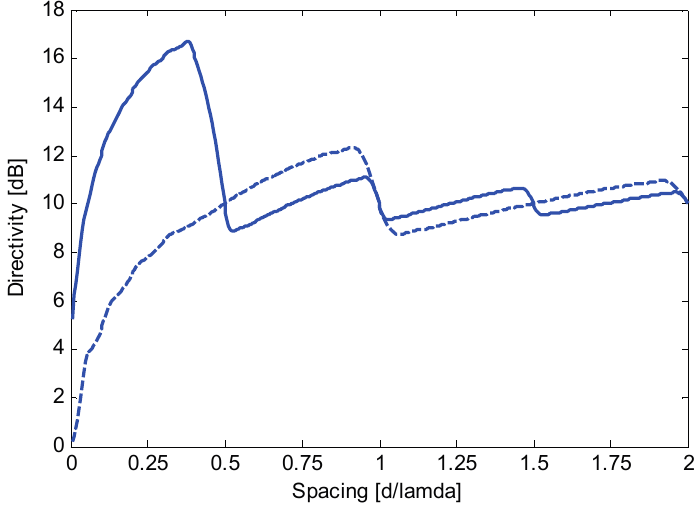
Figure 1. Maximum constrained directivity obtained for a 10-element array versus the normalized inter-element spacing ( i.e. , d / λ ) for end-fire (solid line) and broadside (dashed line) steering. Optimum weights are computed by imposing WNG ≥ 0 dB and solving Equation